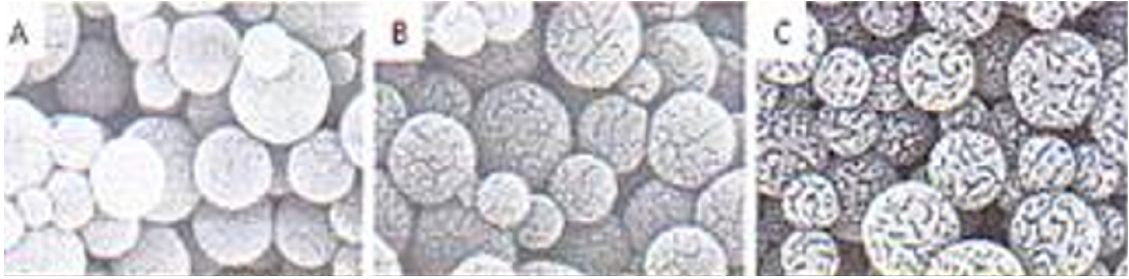
Figure 11. Porous spherical carbon particles for supercapacitor electrodes. Representative electron micrographs showing ( A ) Pristine carbon nanospheres prepared by HTS; ( B ) Carbon spheres after carbonization; ( C ) Carbon spheres after graphitization.